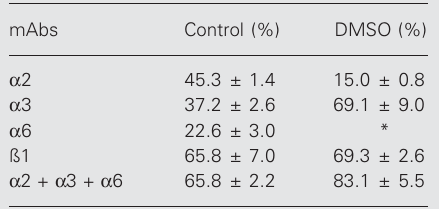
Table 2. Dimethyl sulfoxide (DMSO, 2.5%, v/v) inhibits laminin-1 adhesion to LISP-1